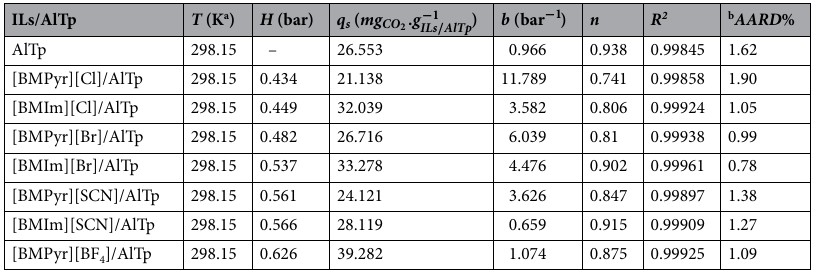
Table 3. Henry’s law constant ( H), q s and b are also parameters of the Khan model, the dimensionless adsorbent parameter ( n ), the correlation coefficient ( R 2 ) and absolute average relative deviation ( AARD ) for CO 2 adsorption ILs/AlTp at 298.15 K. a Standard uncertainty is u( T ) = 0.05 K. b AARD % = 100 n